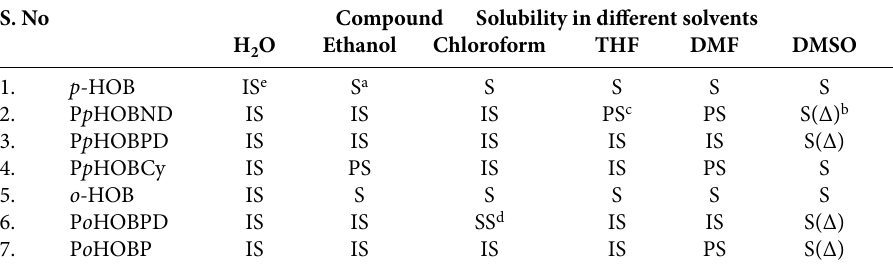
Table 1. Solubility of monomers and polymers in different solvents at the concentration of 5mg/ 5 ml S. No